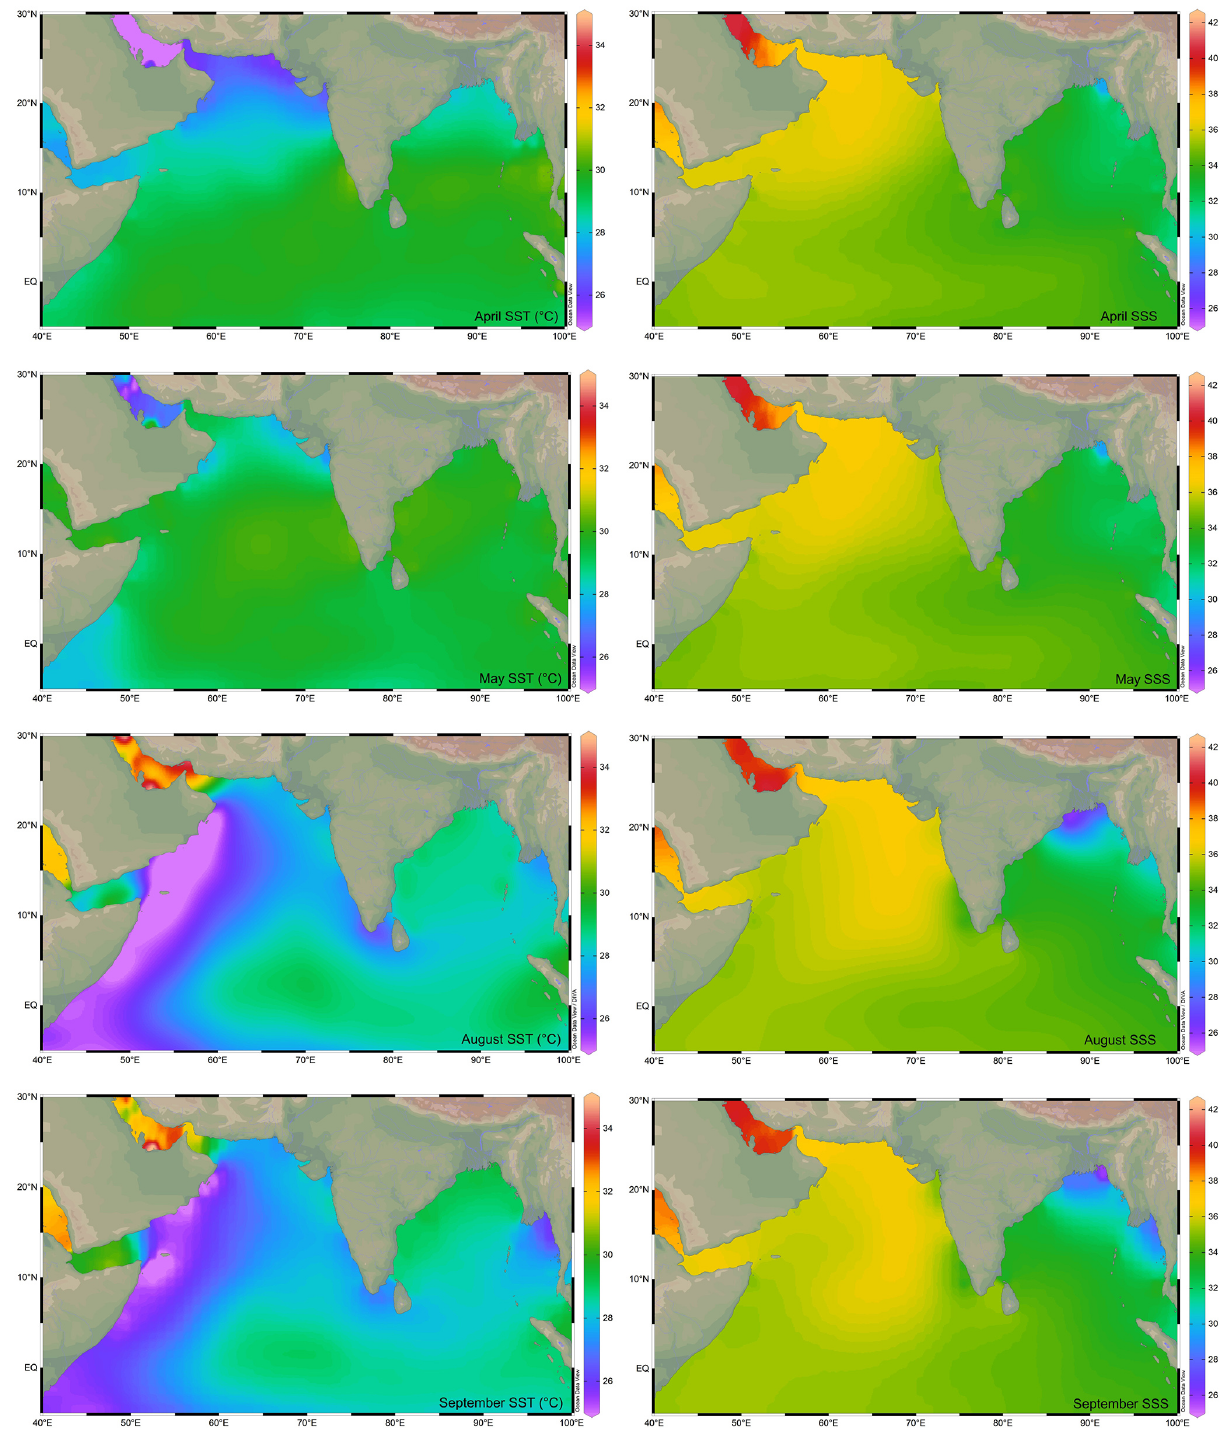
Figure 1. The sea surface temperature (SST; ◦ C; Locarnini et al., 2018) and sea surface salinity (SSS; psu; Zweng et al., 2018) in the northern Indian Ocean during the monsoon (August–September) and non-monsoon (April–May) months. The major rivers draining into the northern Indian Ocean are marked by thin blue lines. The map has been prepared by using Ocean Data View software (Schlitzer, 2018).